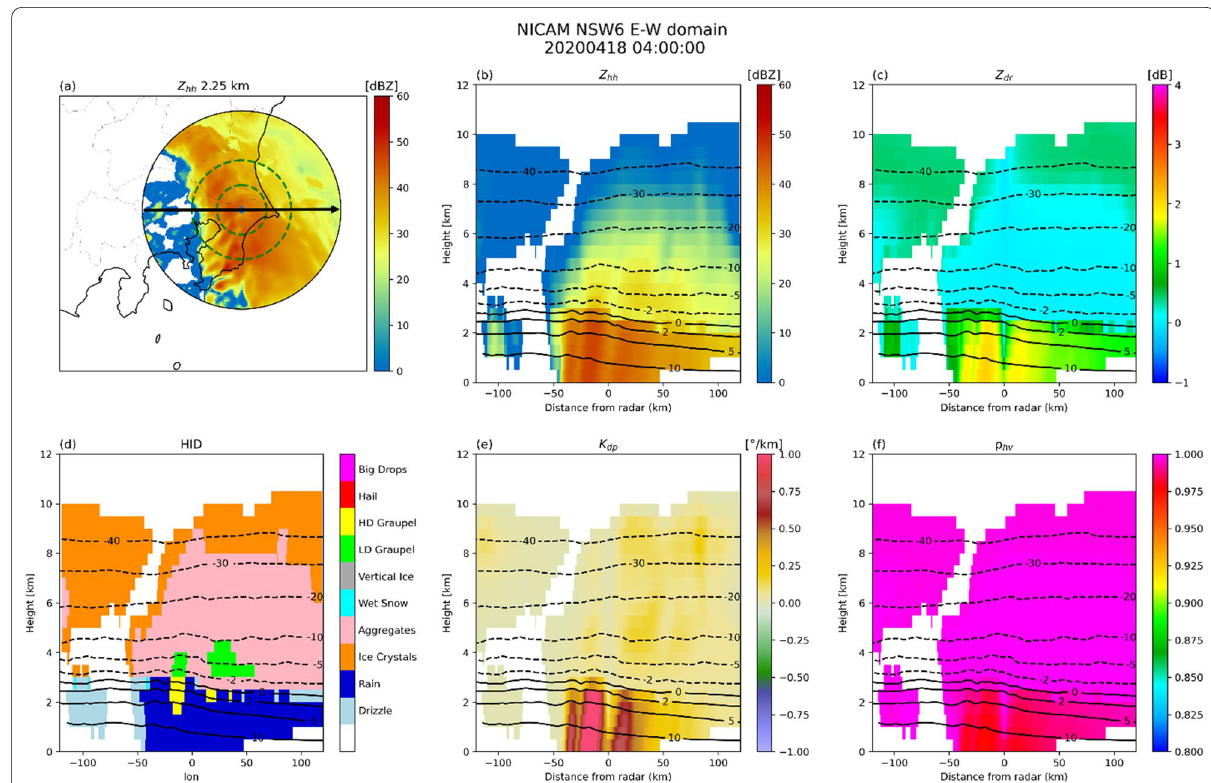
Fig. 7 The same as Fig. 6 but for the results of the NICAM-NSW6 simulation. The cross sections are shown for the east–west direction designated by the red line in the top-left panel. The contours in the cross section show the temperature